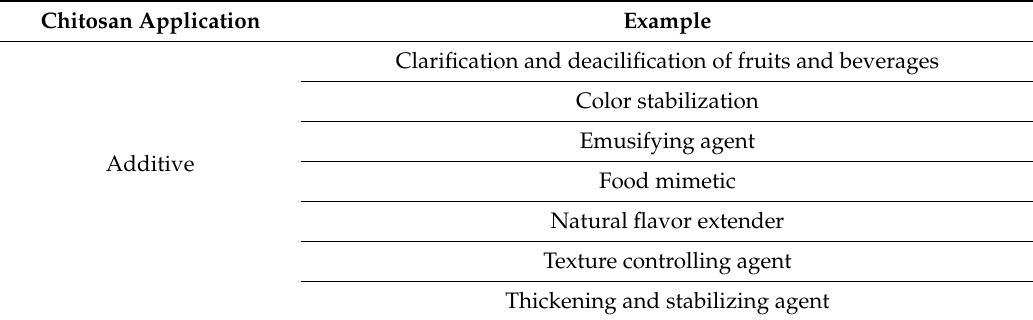
Table 7. Applications of chitosan in the field of food and